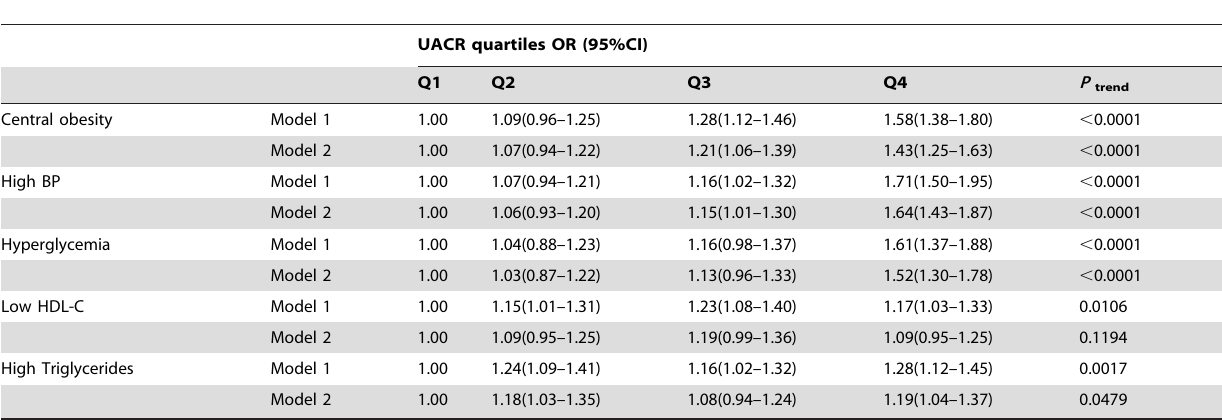
Table 4. Elevated UACR quartiles associated with the prevalence of MetS